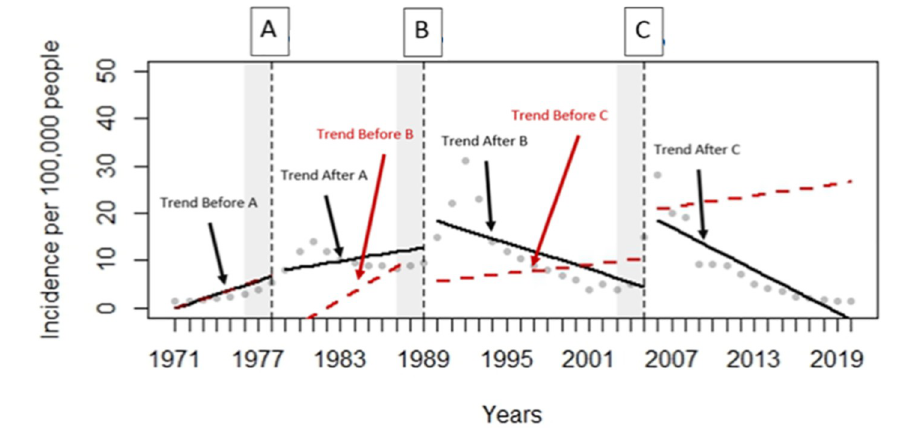
Fig 5. Incidence of cutaneous leishmaniasis (CL) cases before and after three major events. Vertical lines indicate the two years after every event; dotted line indicates the observed incidence of CL; dashed line indicates the trend before every event; solid line indicates the trend after every event in Bam, southeastern Iran (1971–2020).